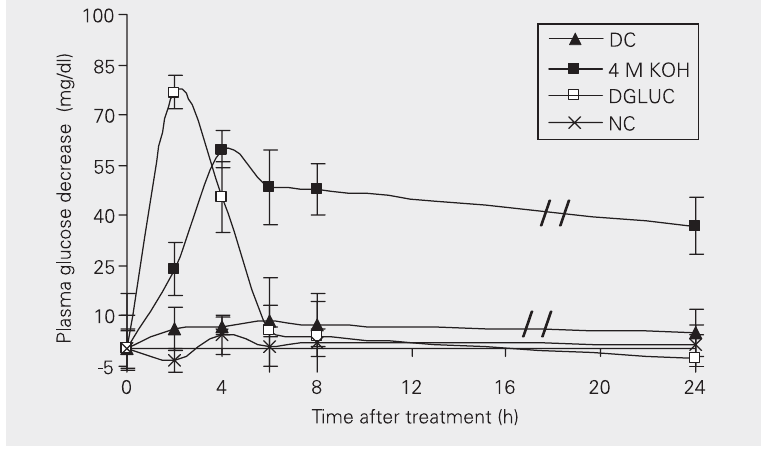
Figure 4. Anti-diabetic effect of intraperitoneal administration of ß-glucan from barley (DGLUC) and of the 4 M KOH hemicellulose fraction of Rhynchelytrum repens (4 M KOH) on rats with streptozotocin-induced diabetes. DC = diabetic control; NC = normal control. N = 10 for each group. P < 0.05 (ANOVA followed by Tukey